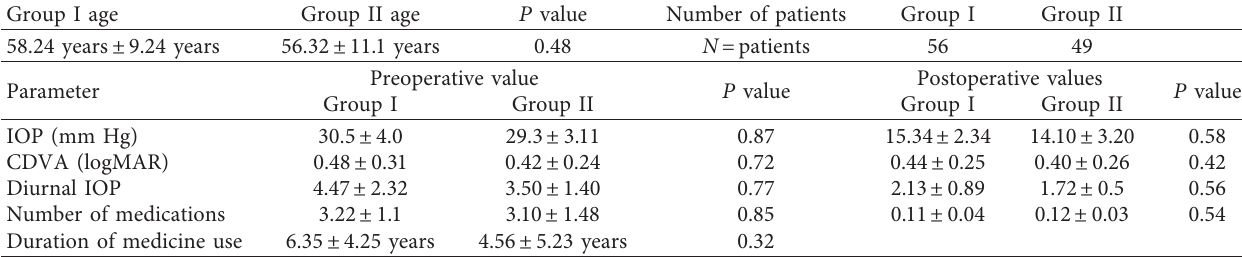
Table 1: Phakic patients: descriptive statistics.